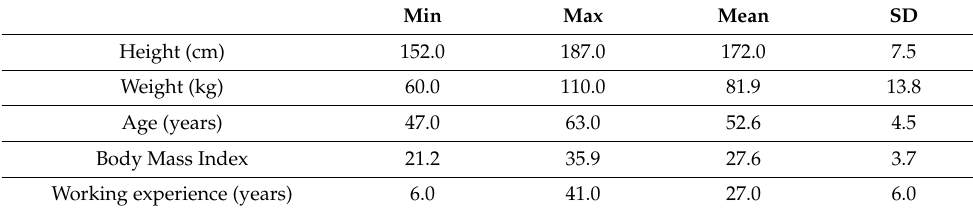
Table 3. Demographic information from the 40 loggers participating in the study. Min